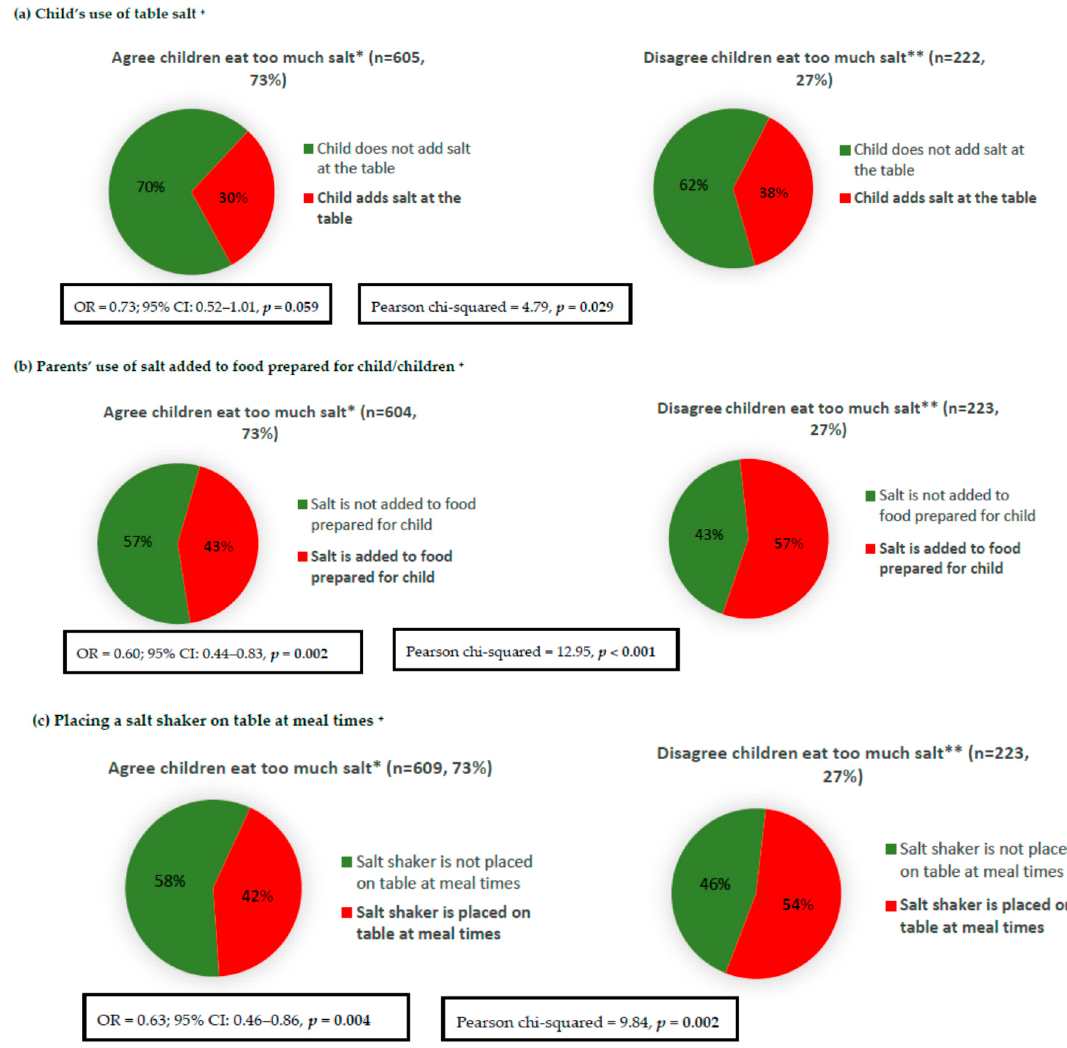
Figure 4. Association between parents’ knowledge that Australian children eat too much salt and discretionary salt use behaviours related to their child/children. * Figure 4 responses include ‘far too much’ and ‘too much’; ** Figure 4 responses include ‘just the right amount’, ‘too little’, ‘far too little’, and ‘don’t know’; + Logistic regression adjusted for parent’s age, sex, and SES.